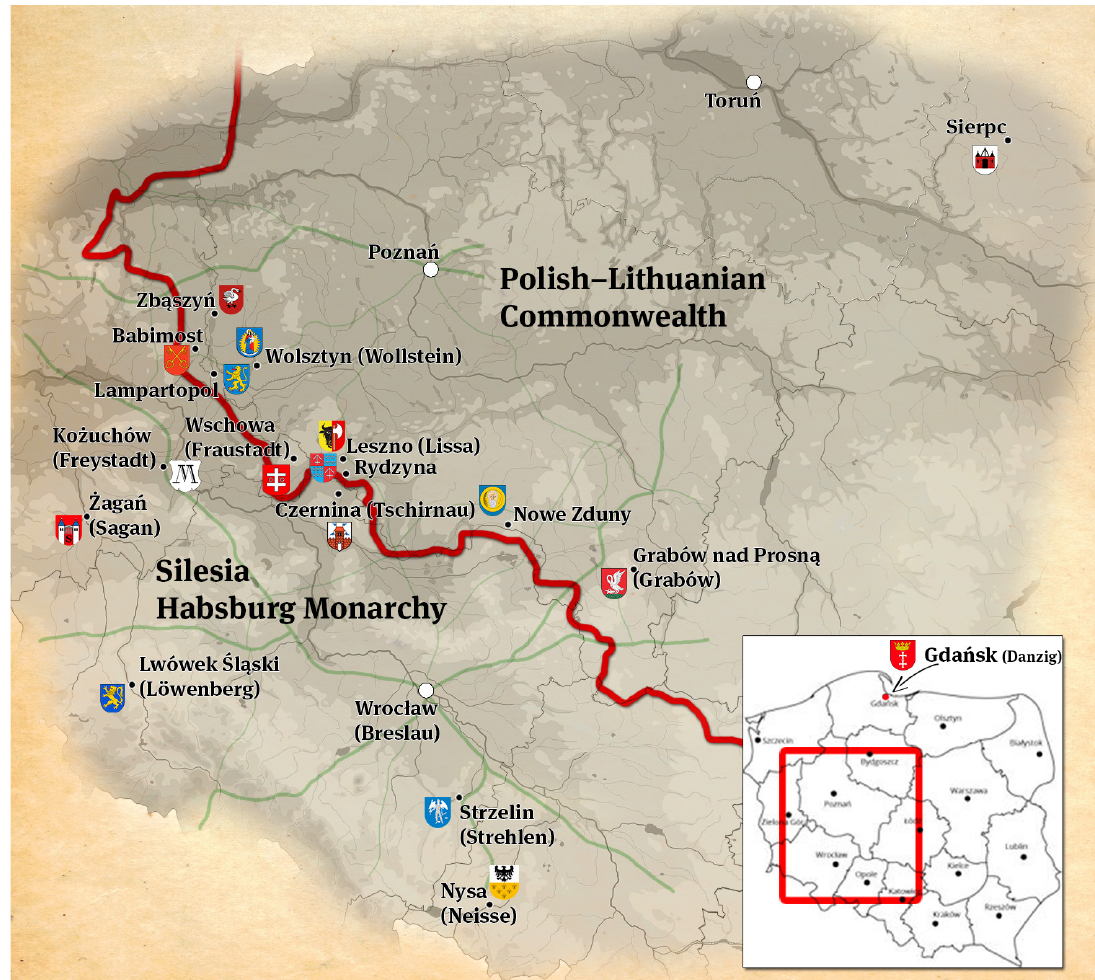
Figure 24. Map showing places of origin of cloth seals from the discussed excavations. Cloth production in many small towns of Greater Poland only lasted for twenty years from 1630s up to 1650s ending abruptly with the tremendous destruction of the area by the Swedish army during the Second Northern War